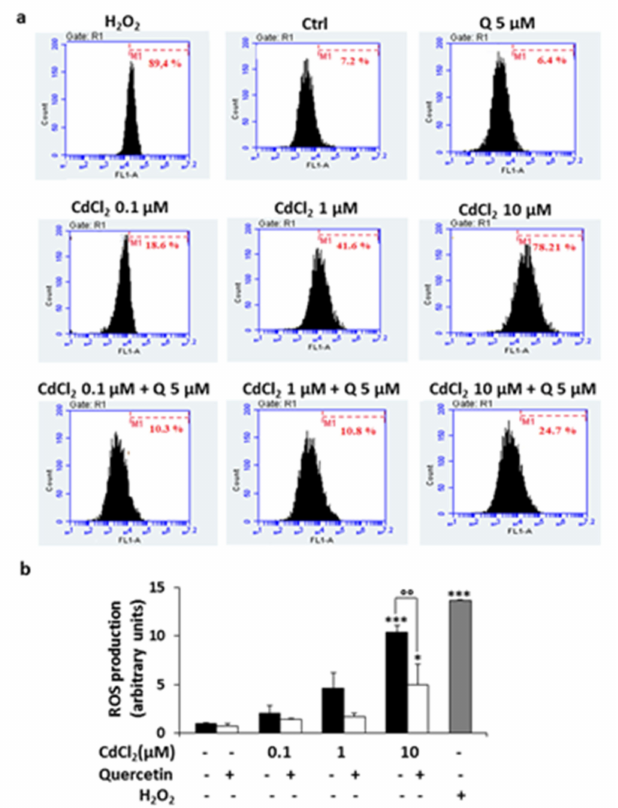
Figure 3. ROS determination in Nthy-ori-3-1 exposed to CdCl 2 and quercetin. Cells were pretreated for 24 h with or without quercetin (Q) 5 µ M and then exposed for 2 h at the indicated concentrations of CdCl 2 ; after incubation with H2DCF-DA, the fluorescence of DCF was evaluated by flow cytometry. In panel ( a ), cytofluorimetric plots of a representative experiment of three separate determinations are shown. Panel ( b ) shows the ROS production expressed as fold of increase with respect to untreated cells (Ctrl) considered arbitrarily as 1. H 2 O 2 (150 µ M) was used as the internal positive control. The results represent the mean ± SD of three independent experiments. Statistical analysis was performed using the Tukey–Kramer multiple comparisons test. * p < 0.05, *** p < 0.01 vs. Ctrl; ◦◦ p < 0.01 vs. CdCl µ 2 10